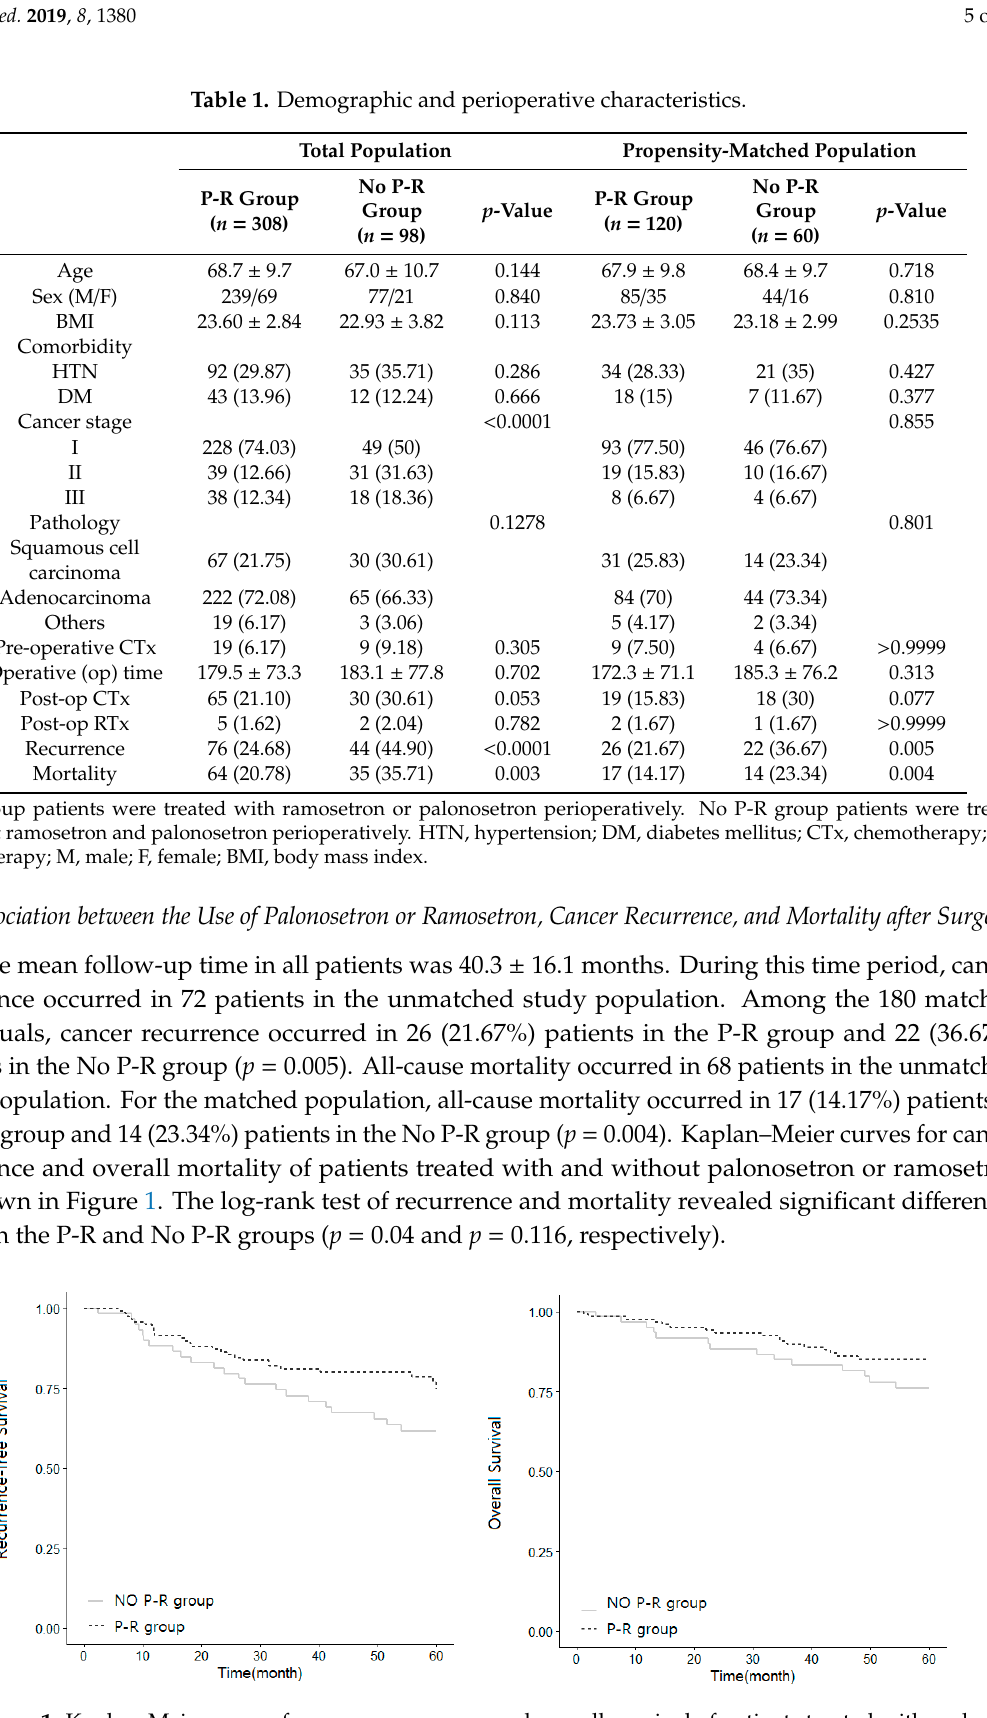
Figure 1. Kaplan–Meier curves for cancer recurrence and overall survival of patients treated with and without palonosetron or ramosetron. P-R group patients were treated with ramosetron or palonosetron perioperatively. No P-R group patients were treated without ramosetron and palonosetron perioperatively.